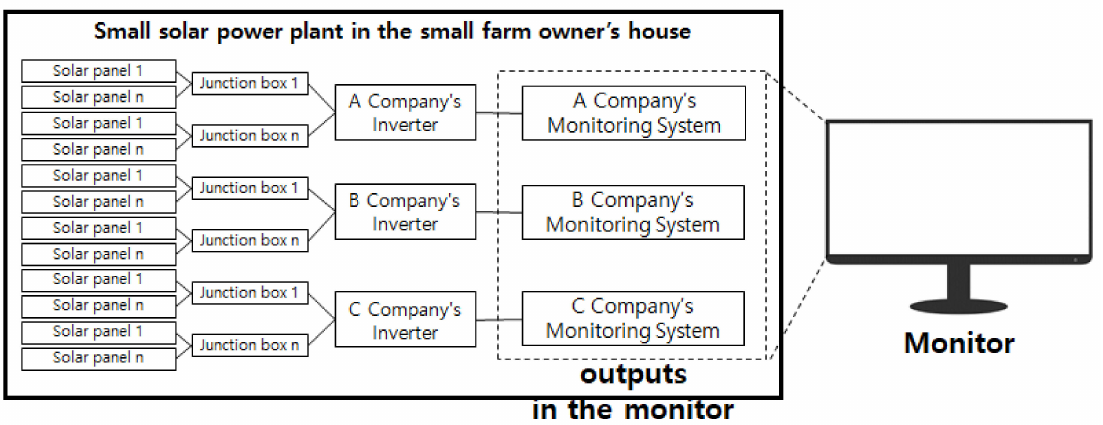
Figure 2. Structure of common solar energy monitoring